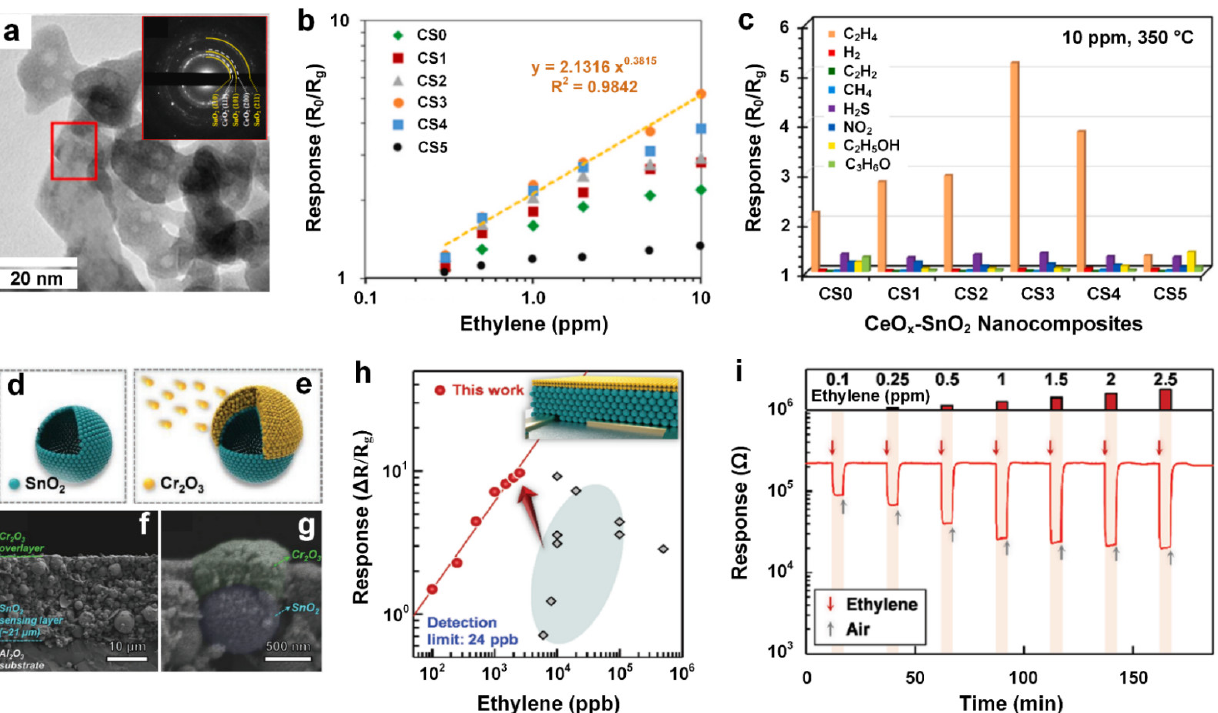
Figure 10. TEM ( a ) and SAED (inset) images of CS3. The relationship of response versus ethylene gas concentration ( b ), as well as selectivity among a ranged of interfering gases ( c ) of all CS sensors. Reproduced from Ref. [57] with permission from Elsevier. The schematic formation of nanostructured SnO 2 ( d ) and Cr 2 O 3 overlayer ( e ). Side views of the Cr 2 O 3 -SnO 2 bilayer ( f ) and the magnification ( g ). Plot of the response against the concentration of ethylene gas ( h ). Inset: the schematic of the Cr 2 O 3 -SnO 2 bilayer. Dynamic ethylene sensing transients at different concentrations ( i ). Reproduced from Ref. [58] with permission from Wiley.